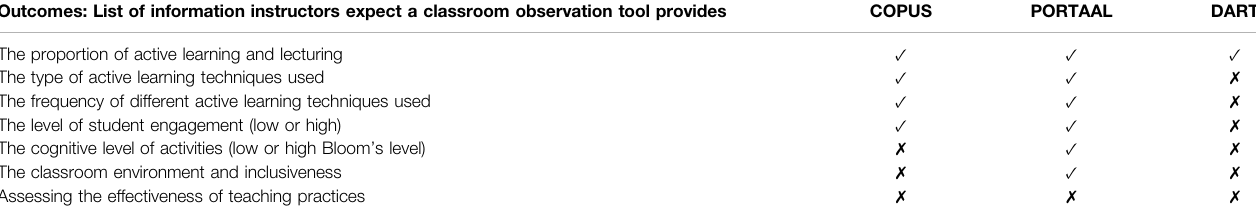
TABLE 4 | Comparison of the fi nal assessment outcomes of COPUS, PORTAAL, and DART with the list of outcomes developed from surveying STEM instructors. Outcomes: List of information instructors expect a classroom observation tool provides